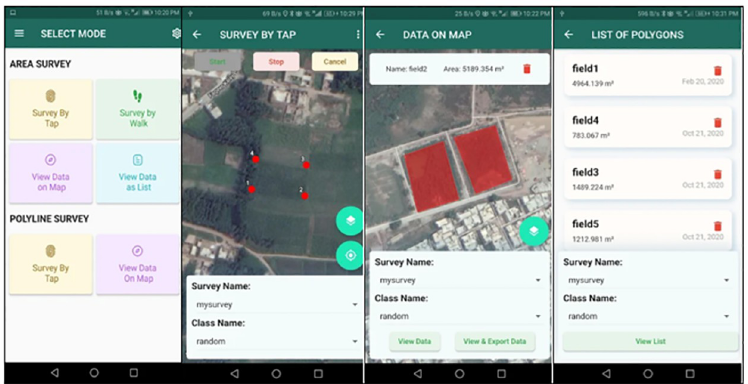
Fig 3. GeoSurvey application with different modes of polygon selection.